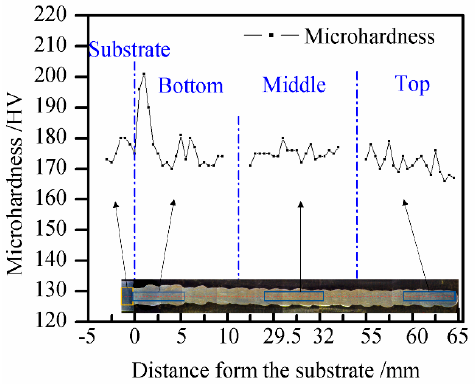
Figure 8. Microhardness profiles of different parts of sample #GRBC-30 cm/min-10 s.